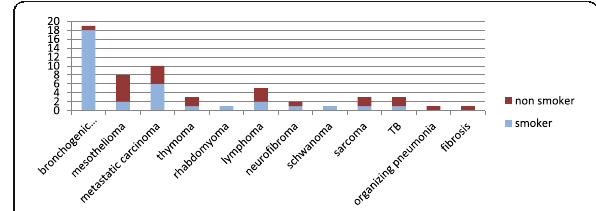
Fig. 5 Bar chart representing smoking state for studied patients and the final diagnosis. TB tuberculosis